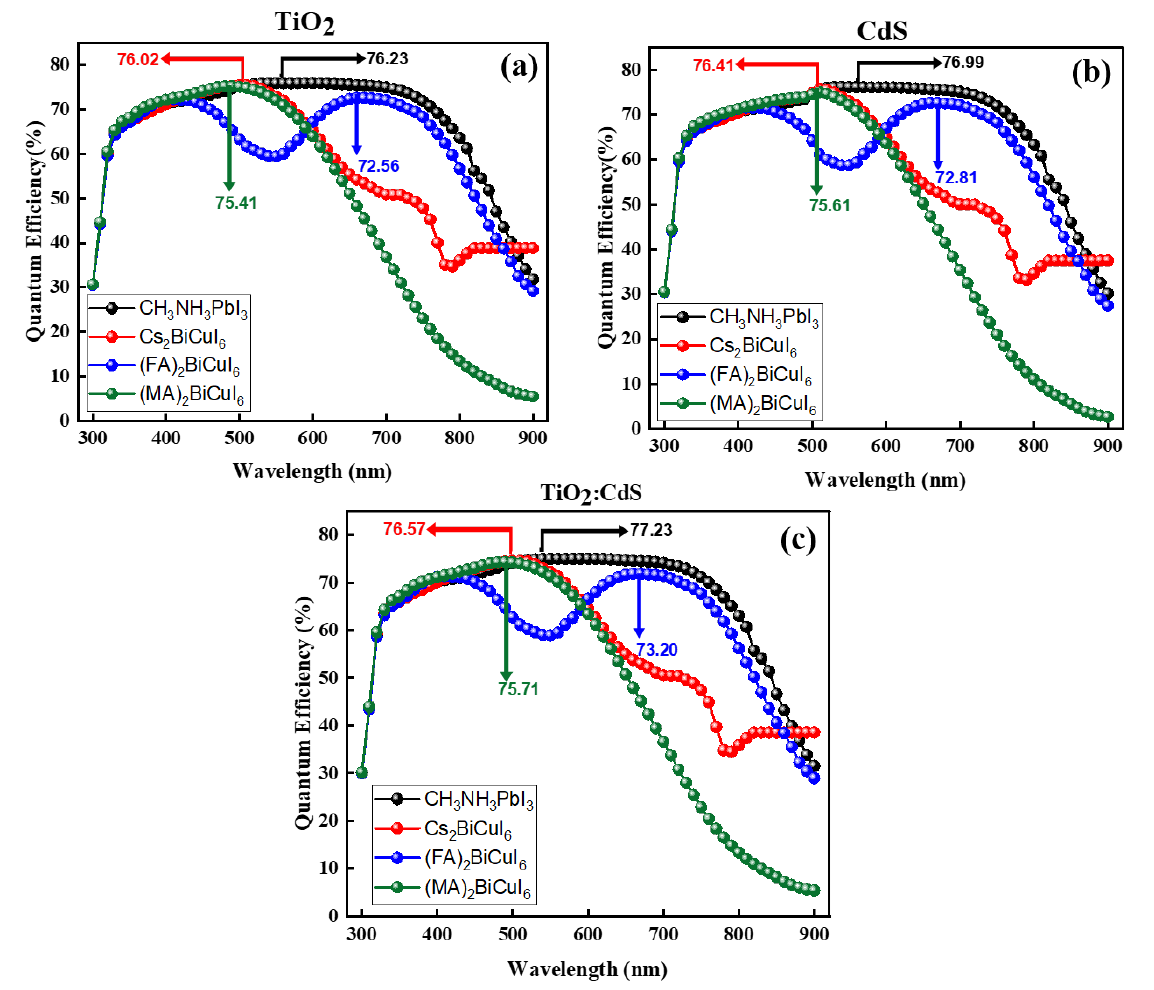
Figure 13. QE curve of different perovskite materials with ETM: ( a ) TiO 2 , ( b ) CdS, and ( c ) TiO 2 :CdS. Table 4. Comparison of published work with simulated device